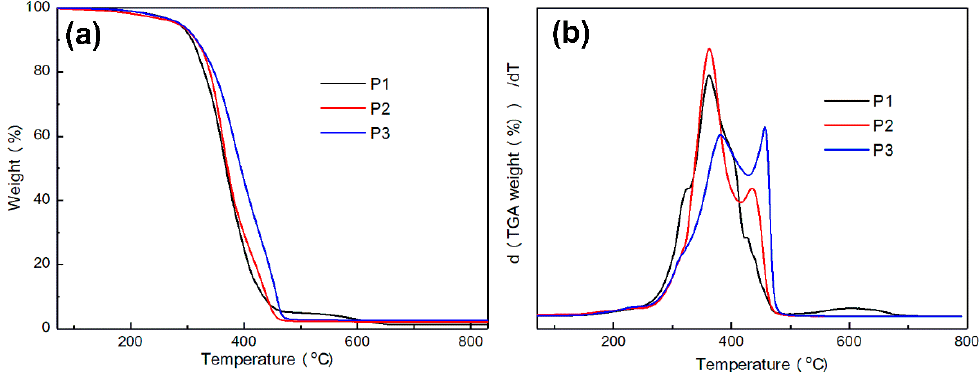
Figure 8. ( a ) The TGA curves of three films and ( b ) the DTGA curves of the three films.